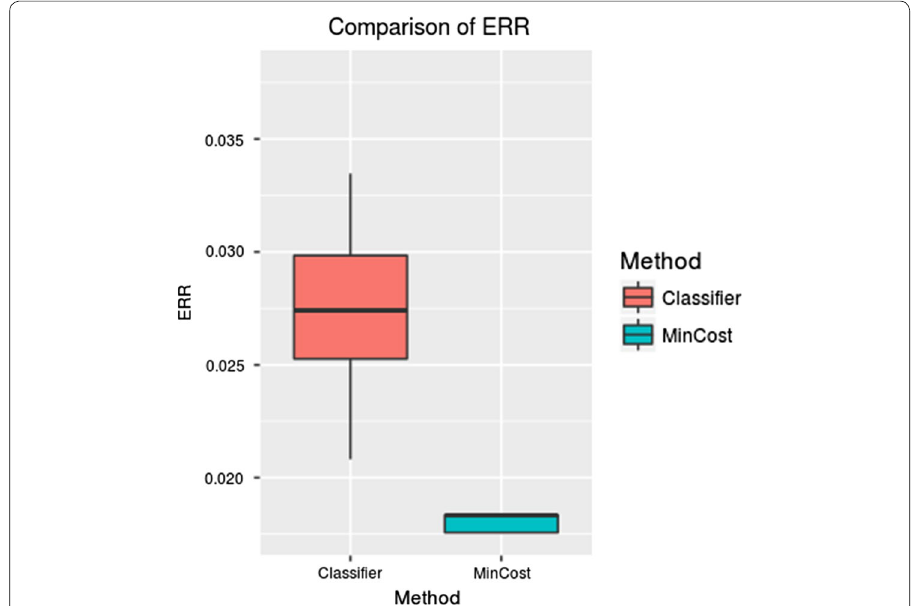
Fig. 7 Comparison of final ERR when initial ERR very